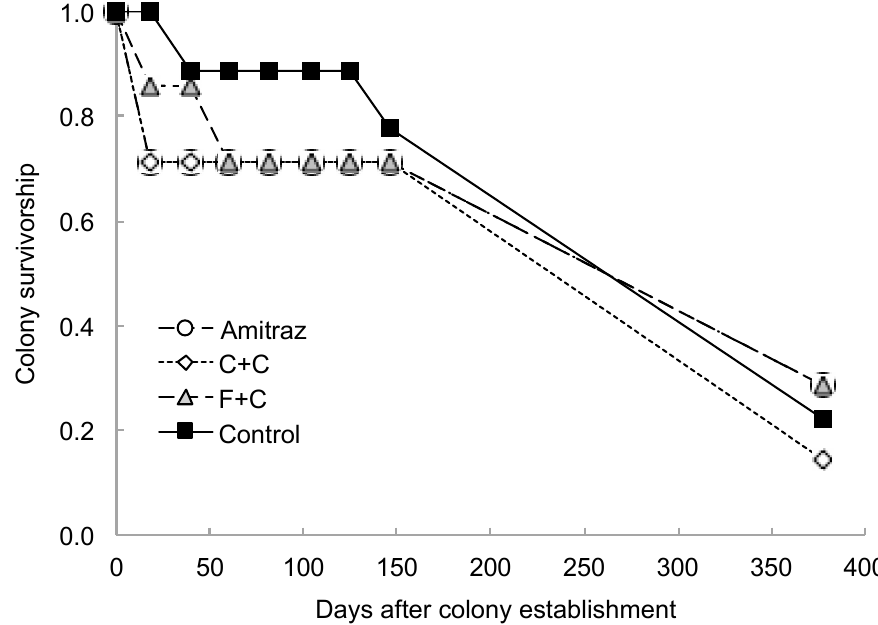
Figure 3. Survivorship curves for colonies established using frames with plastic foundation coated with pesticide-free wax (Control group) or wax exposed to either amitraz (“amitraz” group), a mix of chlorothalonil and chlorpyrifos (“C+C” group), or a mix of tau -fluvalinate and coumaphos (“F+C” group). Colony survival was evaluated every three weeks from May to October 2017. A final evaluation of survivorship was done one year from the establishment date on May 2018. A colony was removed from the study if it was deemed dead or absconded on a given sampling day.